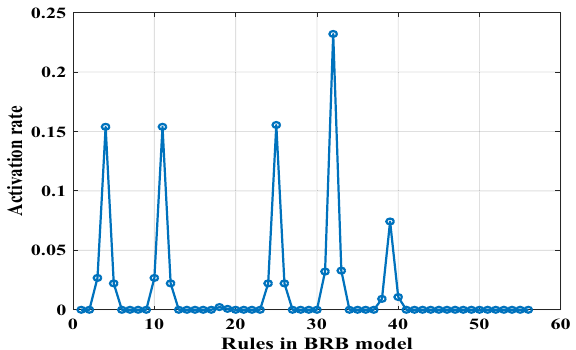
Figure 14. The activation rates of 56 rules in the BRB expert system.